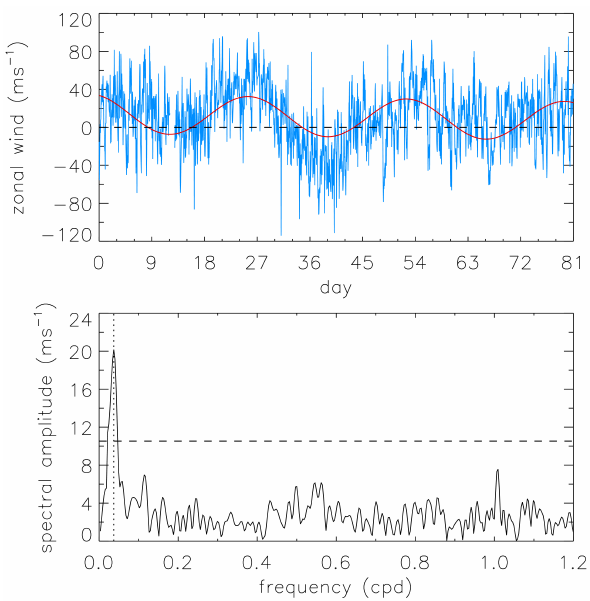
Figure 1. Top: zonal wind observed with Maui meteor radar and fitted oscillation at 90km for 81 days. The blue line denotes the measured wind, and the red line denotes the sum of fitted oscillation and linear trend. Bottom: Lomb–Scargle spectrum of zonal wind at 90km. The dotted vertical line denotes the spectral component corresponding to a period of 27 days, and the dashed horizontal line denotes the confidence level of